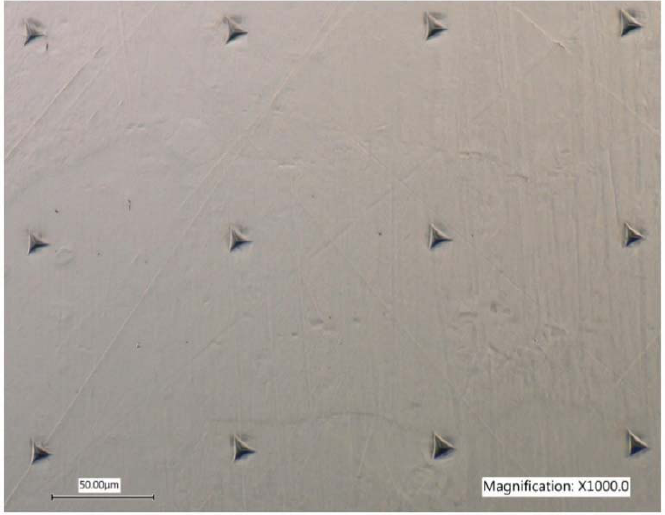
Figure 3. An array of indentation tests to determine indentation hardness and modulus of elasticity.